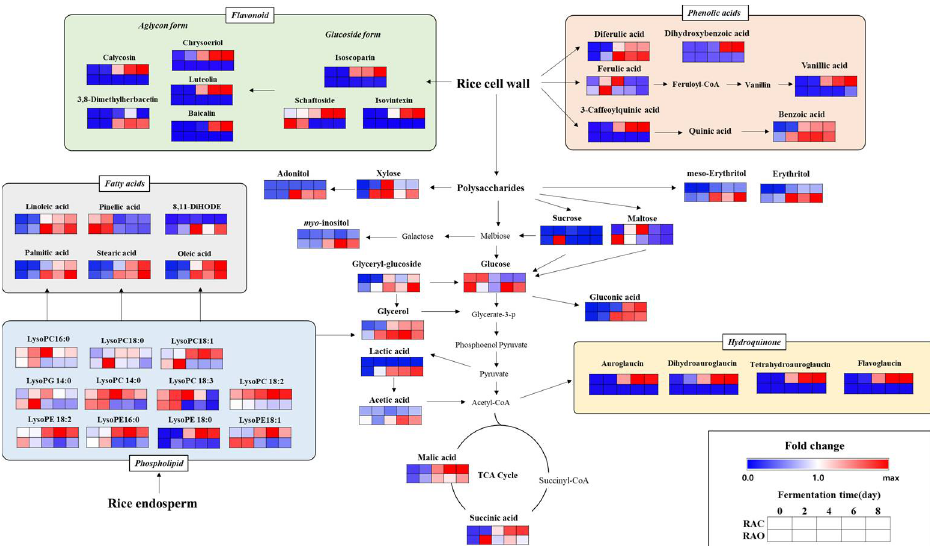
Figure 2. Scheme of the metabolic pathway and relative levels of metabolites in rice koji fermented with Aspergillus cristatus or A. oryzae . The pathway was adapted from the Kyoto Encyclopedia of Genes and Genomes (KEGG) database and modified. The colored squares represent the fold changes (blue to red) normalized by the average of all values for each metabolite.